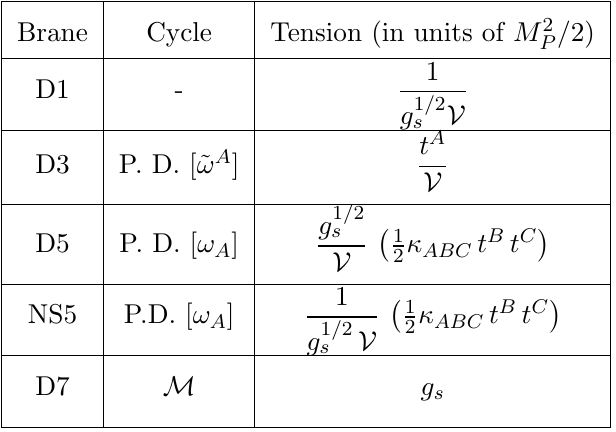
Table 7. DBI tensions of strings formed by branes wrapping even cycles. A runs from 1 to h 1 ; 1 . Cycle A 0 A I B I B 0 Tension (in KCS g 1 = 2 s units of e 2 p V M 3 = 2 (cid:25) ) P Table 8. DBI tensions of domain walls formed by D5-branes wrapping